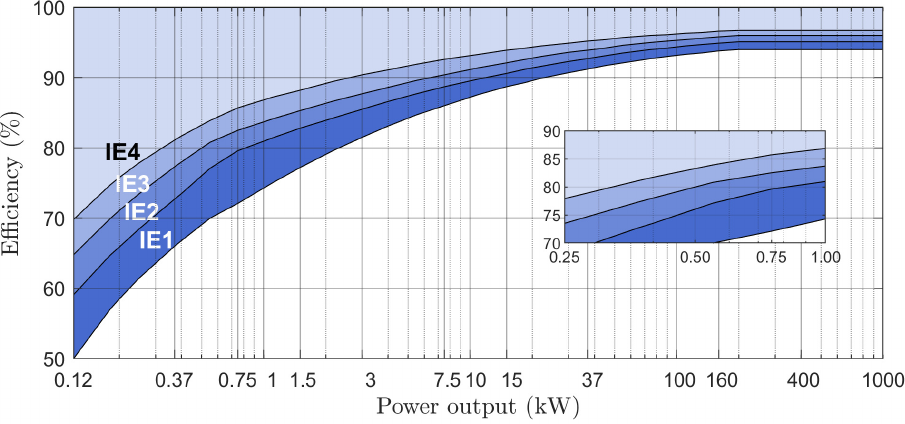
Figure 1. International efficiency classes for four-pole IMs at 50 Hz